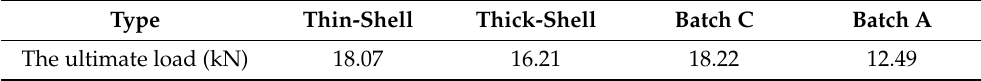
Table 3. Comparison of the theoretical result and the tensile test result. Type Thin-Shell Thick-Shell Batch C Batch A The ultimate load